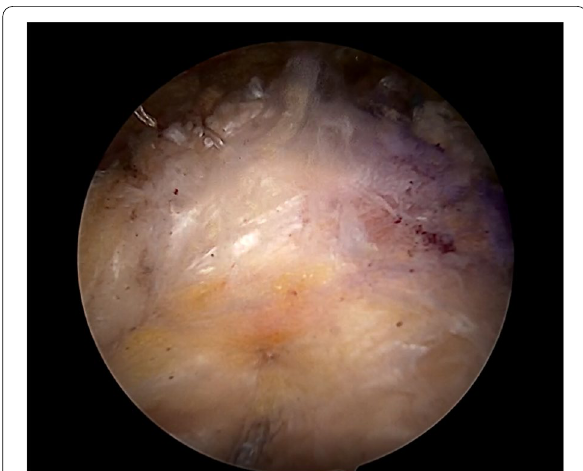
Fig. 3 The tensor fascia lata autograft fixed. The lateral side of the fascia lata was attached to the rotator cuff footprint on the greater tuberosity by using the transosseous equivalent